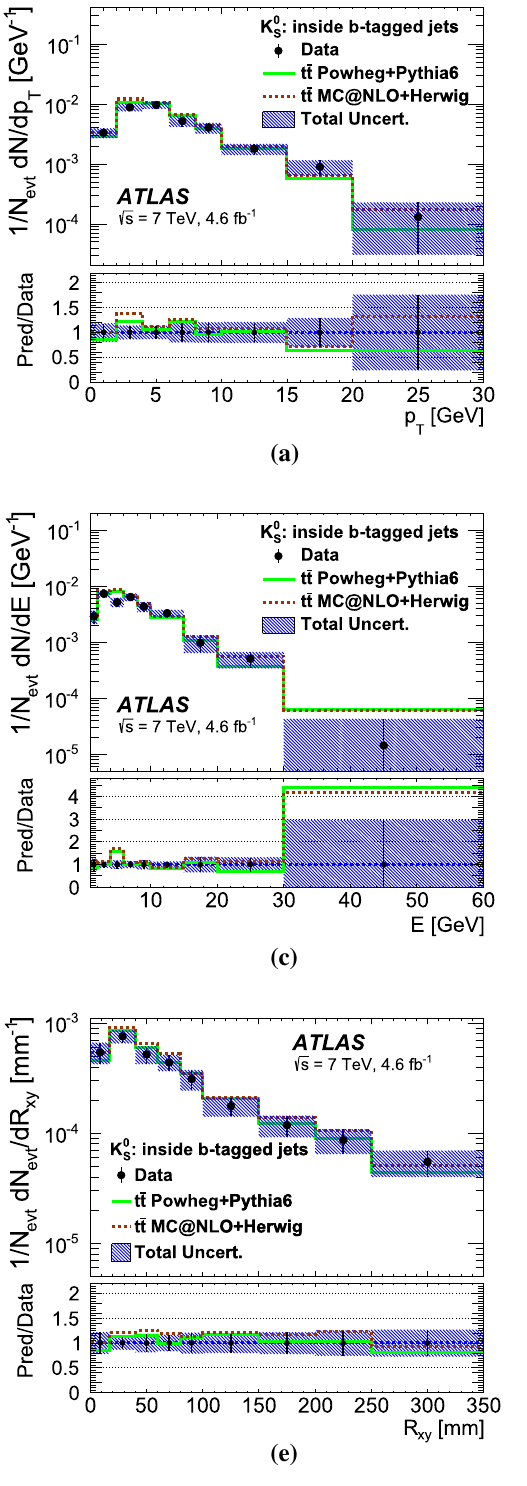
Fig. 3 Kinematic characteristics for K 0 production inside b -tagged are represented by the shaded area. Statistical uncertainties for MC S jets, for data and detector-level MC events simulated with the Powheg samples are negligible in comparison with + Pythia6 and MC@NLO + Herwig generators. Total uncertainties